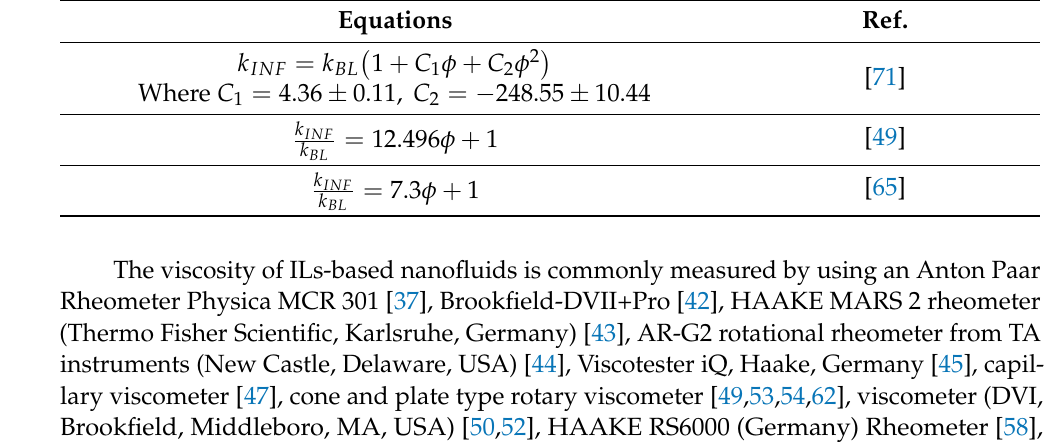
Table 4. Empirical correlations of effective thermal conductivity of ILs-based nanofluids. Equations